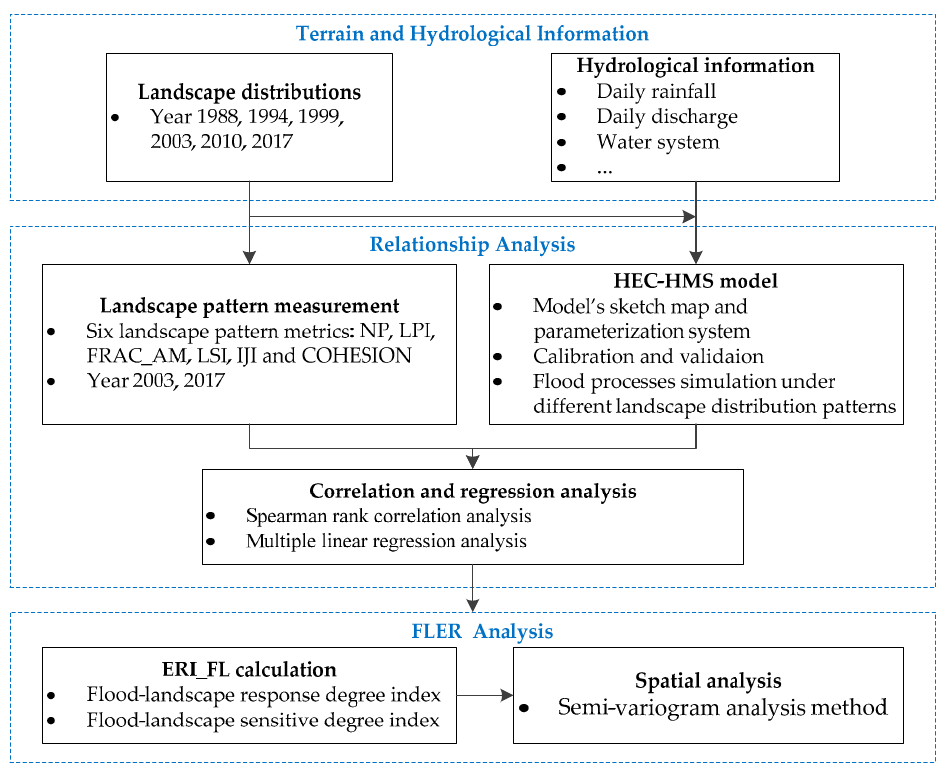
Figure 3. Spatial modeling framework for the evaluation of FLER (flood ‐ landscape ecological risk). ERI_FL: flood ‐ landscape ecological risk